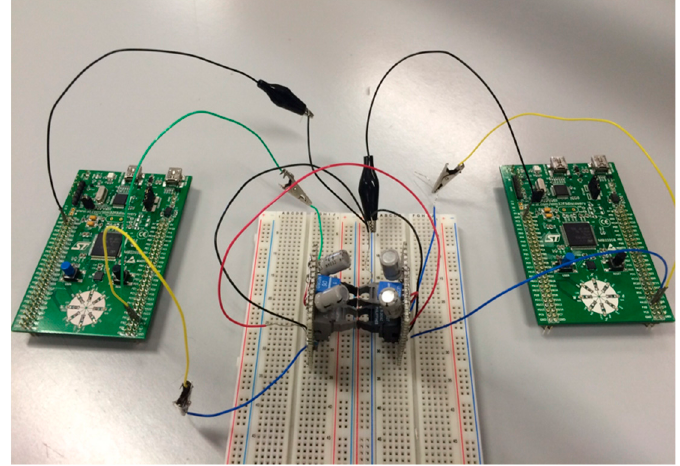
Figure 5. The developed test system includes a board acting as a fixed part, a board acting as removable part, and the transceivers.